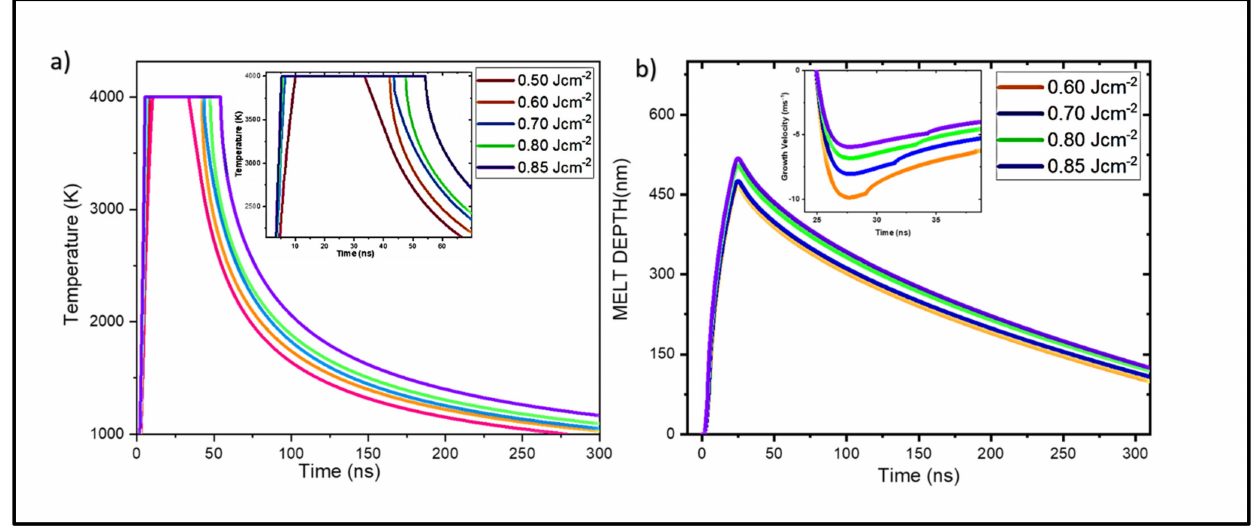
Figure 2. SLIM simulation results: ( a ) Temperature vs. time; ( b ) melt depth vs. time with inset showing the regrowth velocity